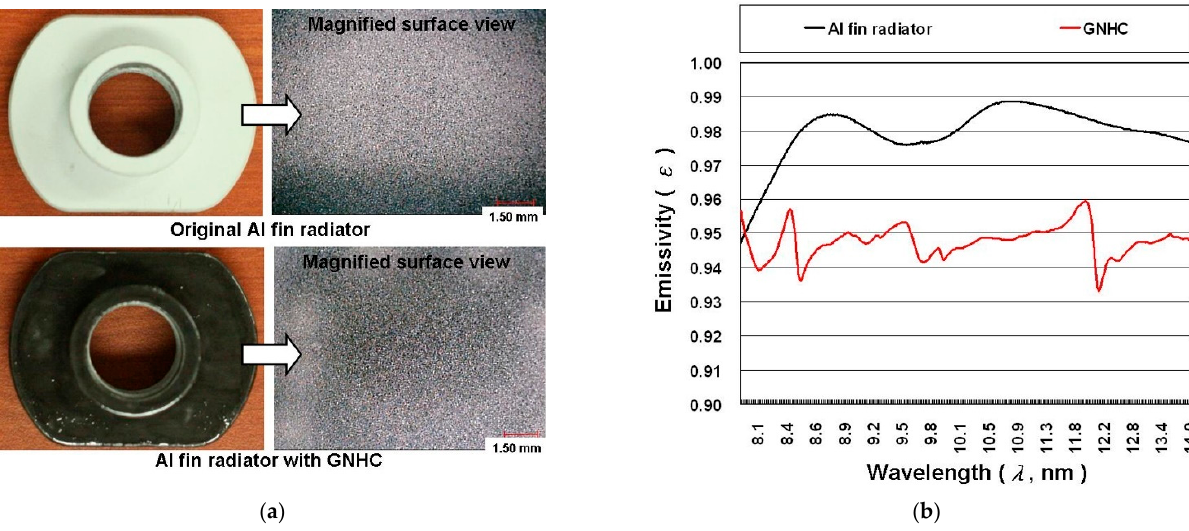
Figure 9. The photographs and ε of aluminum fin radiator with and without GNHC: ( a ) actual photographs; ( b ) ε curves.